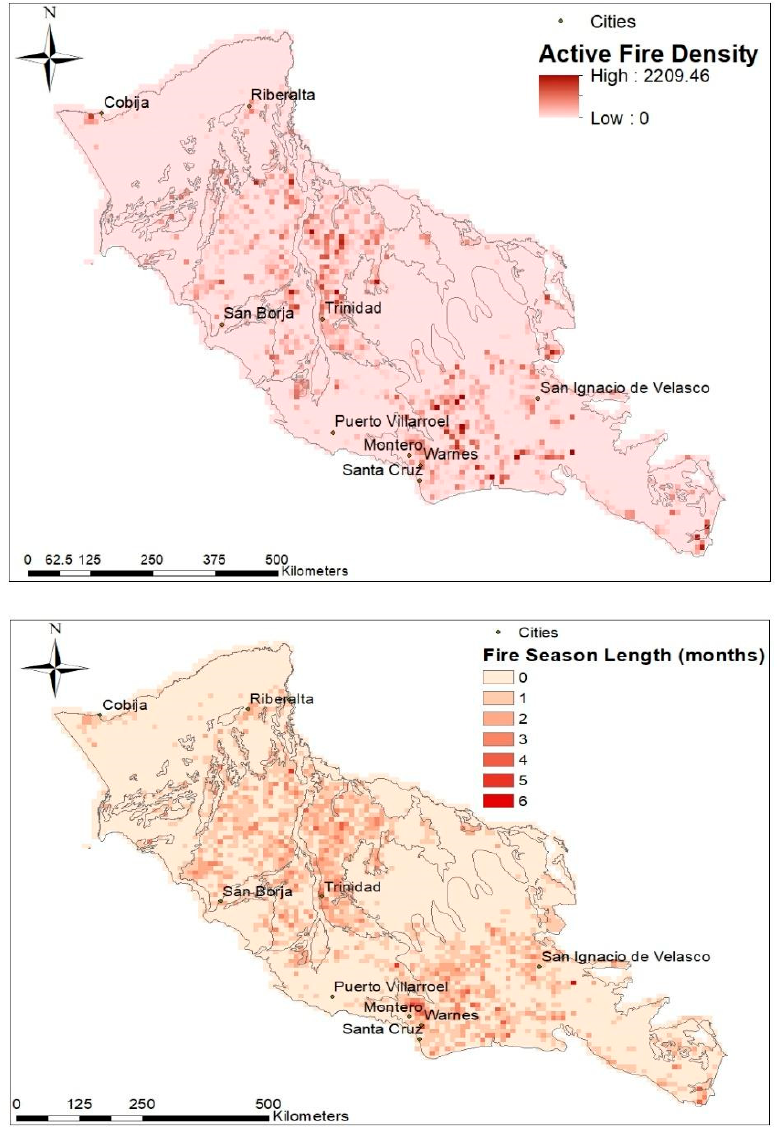
Figure 2. The summative active fire occurrence density (AFOD) ( upper panel ) and the fire season length (FSL) ( lower panel ) within the study area of the Amazonian Basin region of Bolivia between 2001 and 2020. The units were taken from [105].